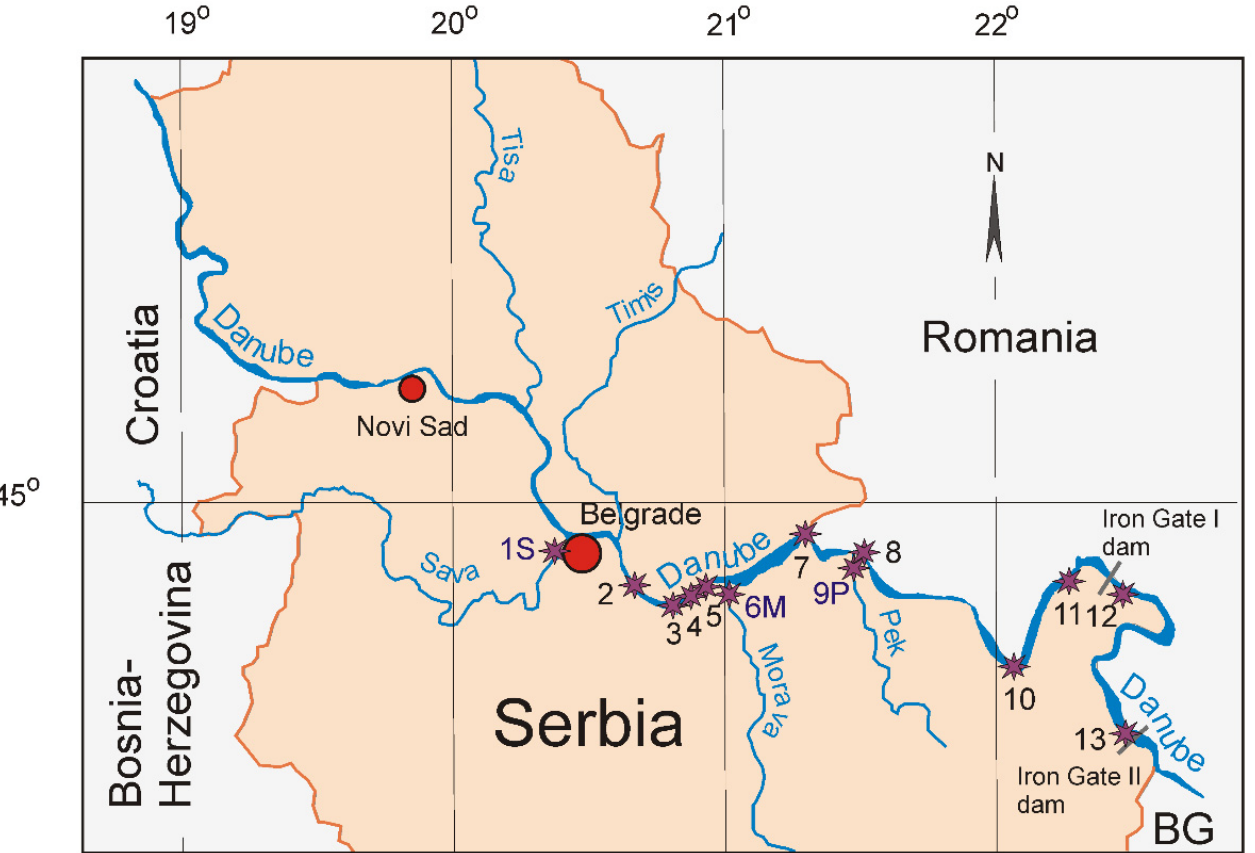
Figure 1. The map of the Serbian sector of Danube River with the location of sampling points. Asterisks mark sampling points, red circles represent main cities.